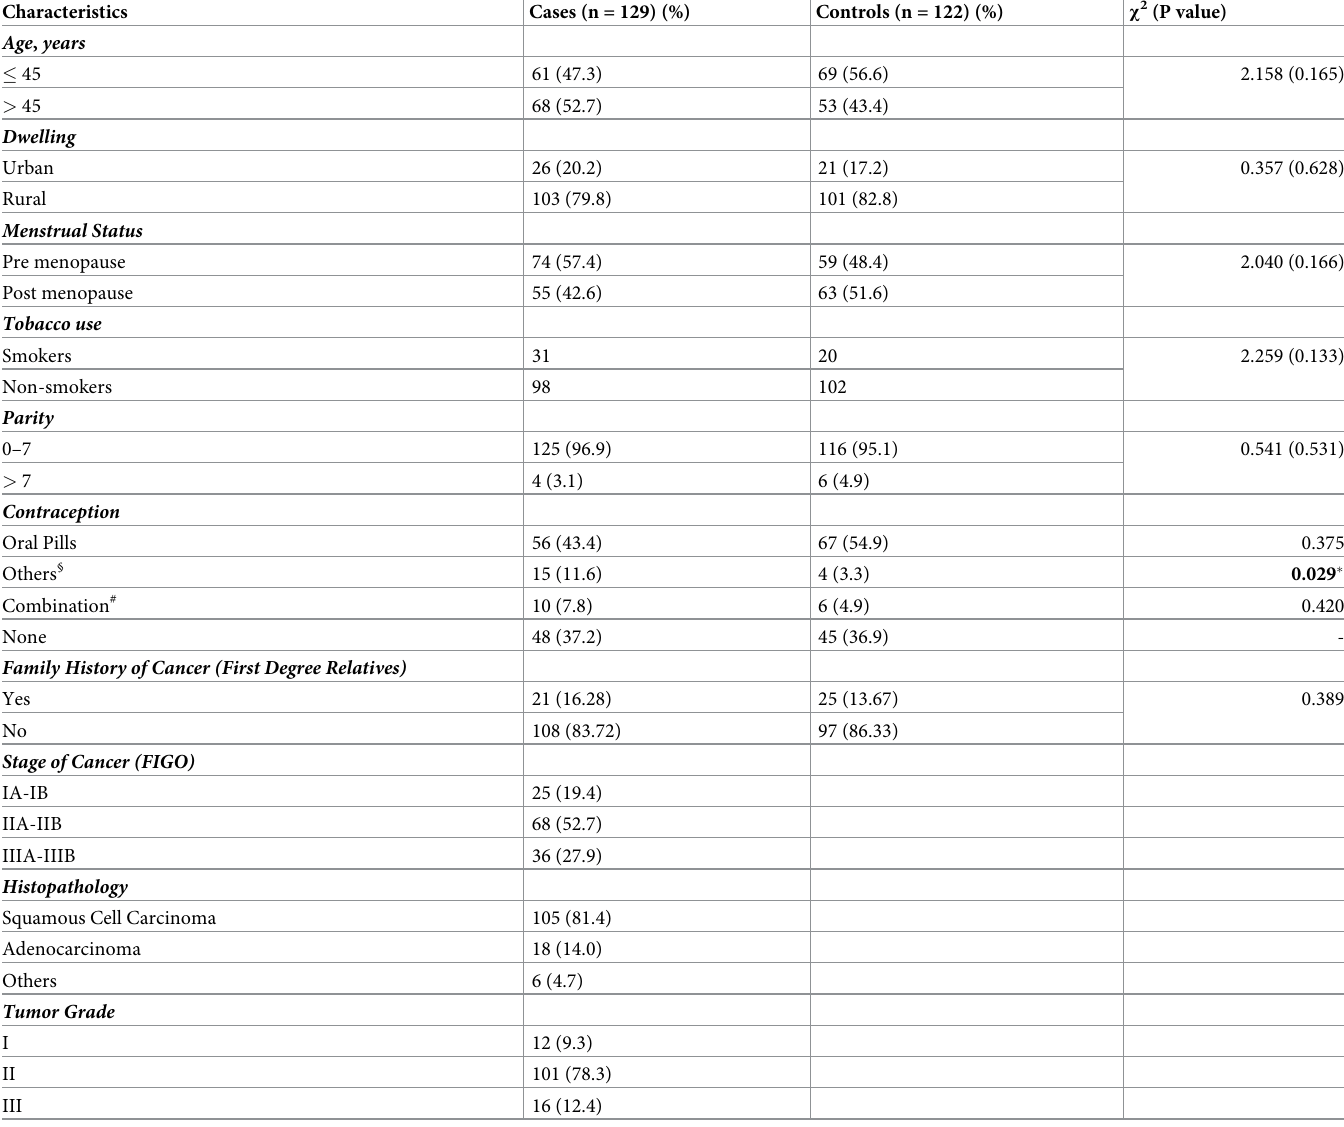
Table 2. Distribution of demographic variables of cervical cancer patients &